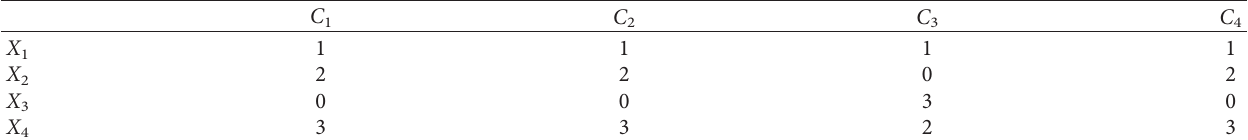
Table 9: Values of positive flow Φ + .